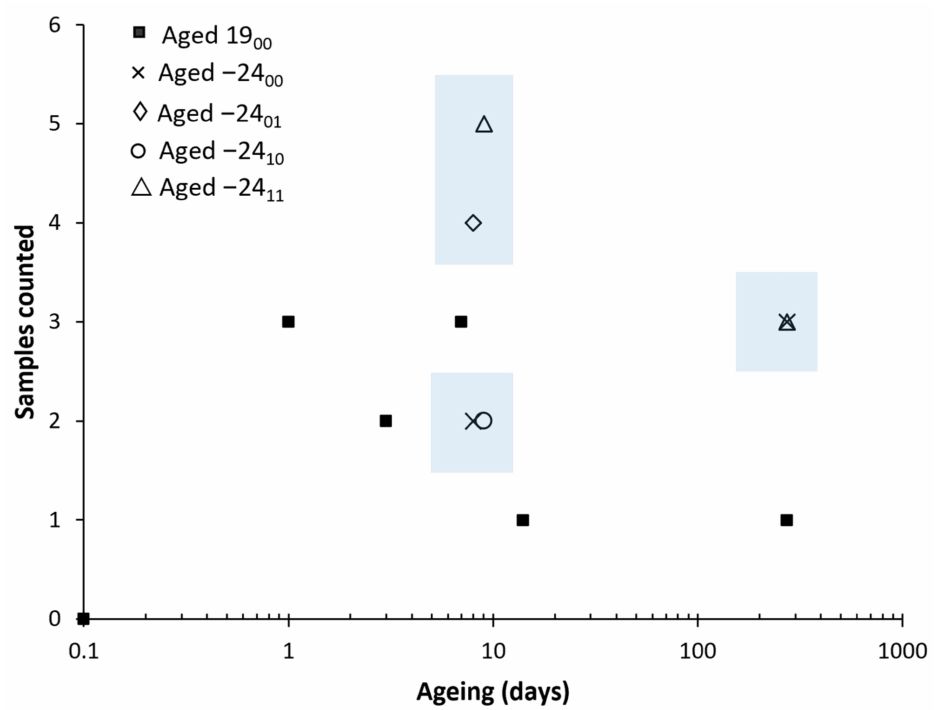
Figure 15. Counts of necking formation. The vertical axis represents how many samples have had a necking out of the six samples tested per material and condition. The shadow area shows the frozen samples. Six samples were measured for each ageing conditions and error bars are the standard